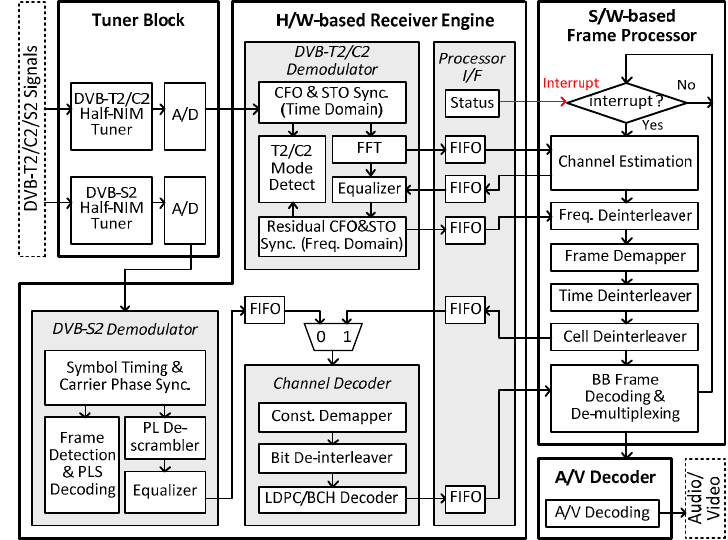
Figure 4. DVB-X2 receiver architecture.